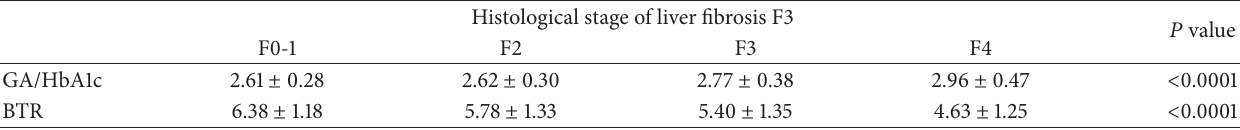
Table 2: Changes in both the GA/HbA1c and the BTR values in HCV-positive patients with histological stage of liver fibrosis.